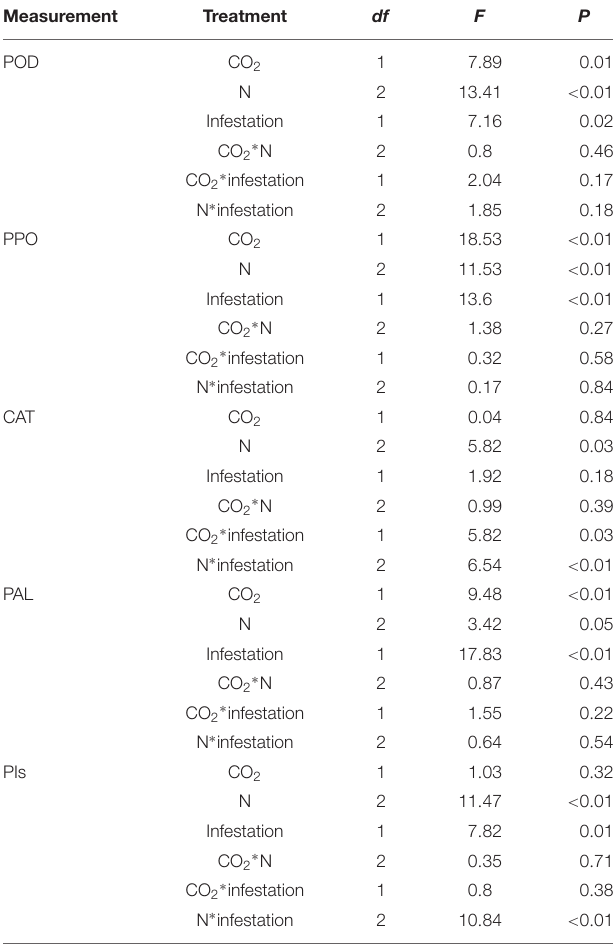
TABLE 4 | Summary of ANOVA results for effects of elevated CO 2 and increased nitrogen fertilization on defensive response of maize.